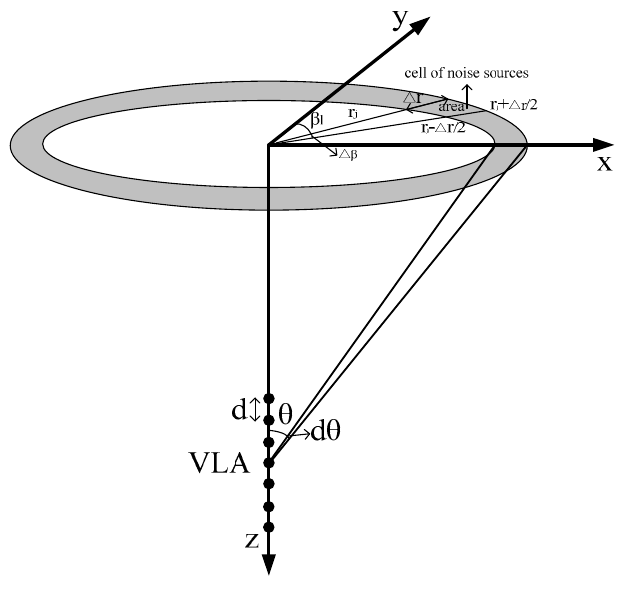
Figure 1. Schematic of ambient noise field modeling.